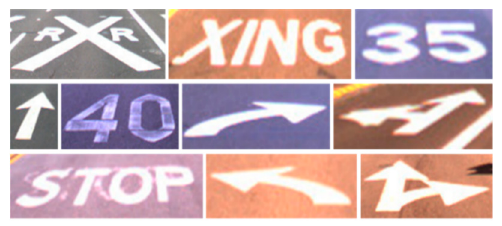
Figure 3. Types of labeled pavement markings.